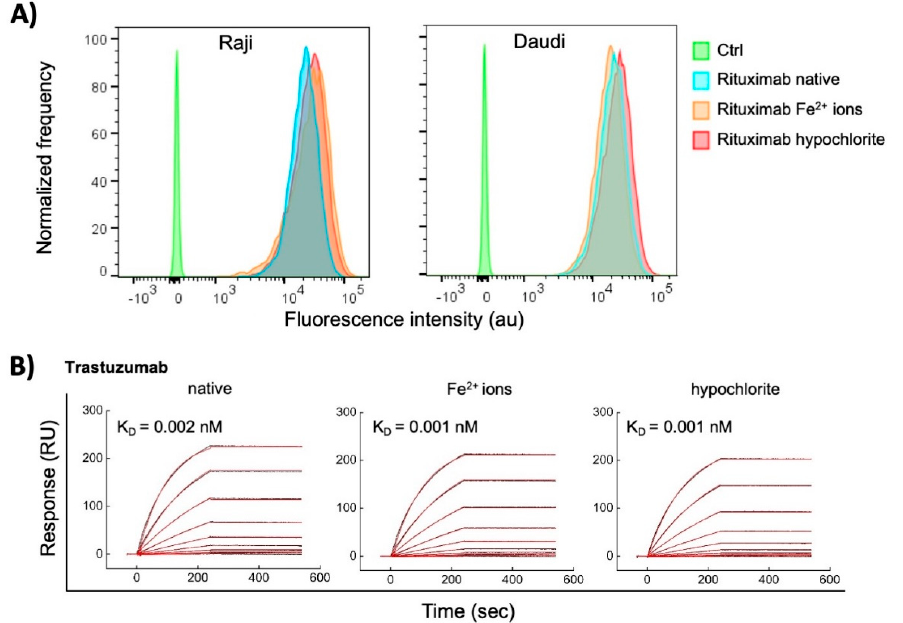
Figure 7. Interaction of native Abs and those treated with redox agents therapeutic with their cog- nate antigens. ( A ) Flow cytometry analyses of binding of Rituximab to human B cell lymphoma cell lines, expressing CD20. Rituximab at 1 mg/mL was exposed to a 500 μ M final concentration of FeSO 4 or 200 μ M NaClO. Native and treated Rituximab at final concentration of 10 μ g/mL was incubated with Raji and Daudi cell lines. The histograms depict the normalized frequency of fluorescence intensity indicating the binding of the Ab to the cell. The control (Ctrl) represents the binding of the secondary anti-human IgG to the cells. ( B ) Surface plasmon resonance evaluation of interactions of Trastuzumab. Real-time interaction profiles of native-, ferrous ion- or hypochlorite-treated Trastuzumab to Her2 immobilized on the sensor chip. Trastuzumab at 1 mg/mL was exposed to 500 μ M final concentration of FeSO 4 or 200 μ M NaClO. The binding profiles of generated after injection of serial dilutions (10–0.039 nM) of native and treated Trastuzumab are presented. The black curves indicate the experimentally observed binding response, the red curve depict the kinetic fit, using global Langmuir analyses. The values of equilibrium dissociation constant are shown within each graph. All interaction analyses were performed at 25 °C.